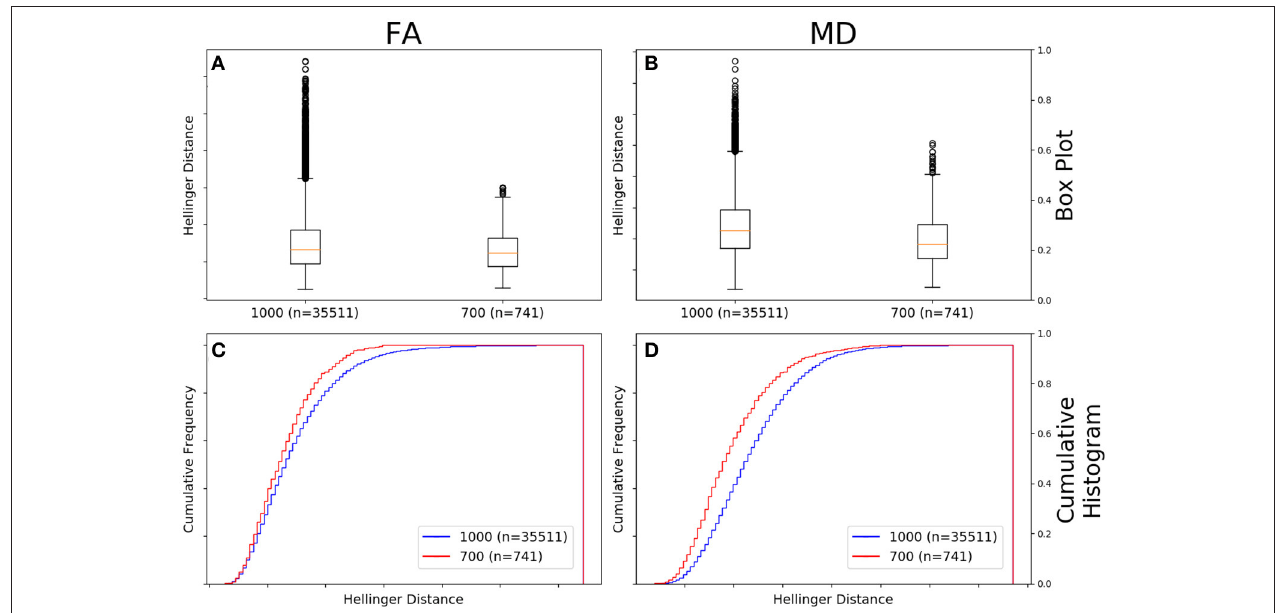
FIGURE 6 | FA (A) and MD (B) map box-and-whisker plot for Siemens b = 1,000 s/mm 2 (number of comparisons = 35,511) vs. Siemens b = 700 s/mm 2 (number of comparisons = 741) data. Cumulative histograms for these data are shown for FA (C) and MD (D) .